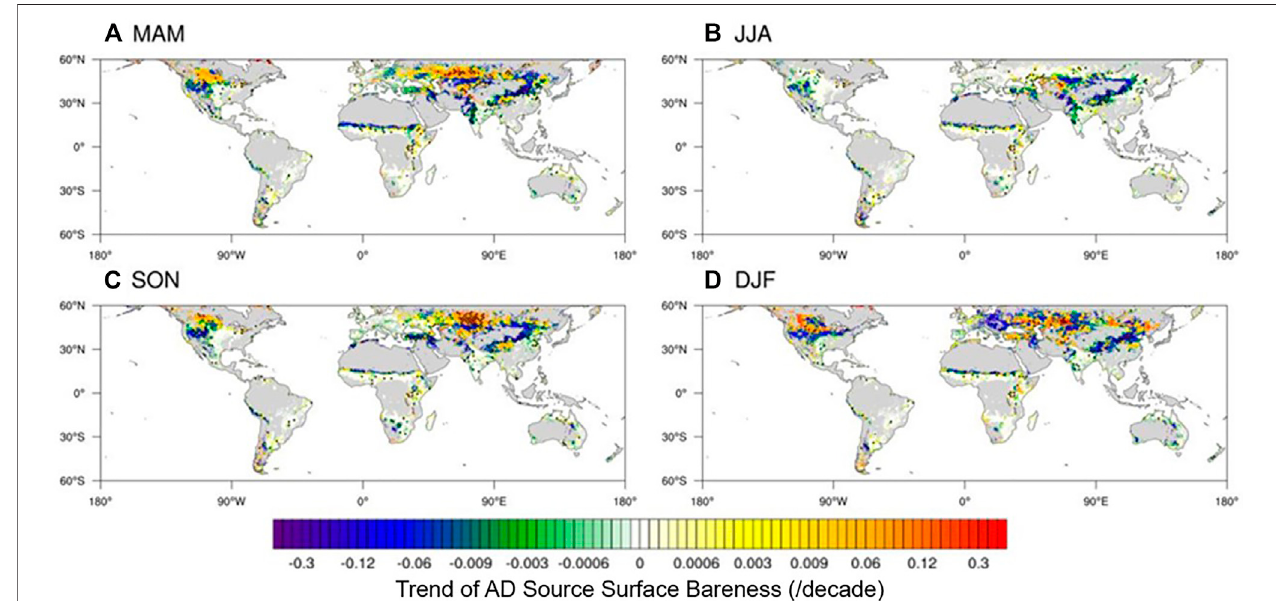
FIGURE 4 | Same as Figure 3 of AD surface bareness.